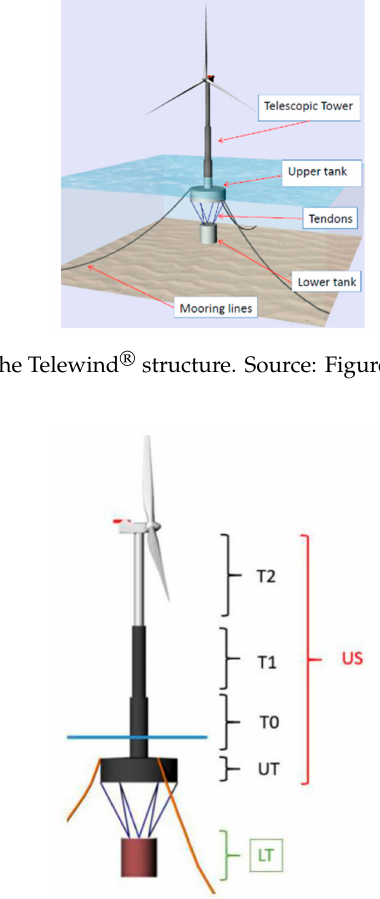
Figure 5. Parts of the Telewind ® platform. Source: Figure courtesy of Esteyco.